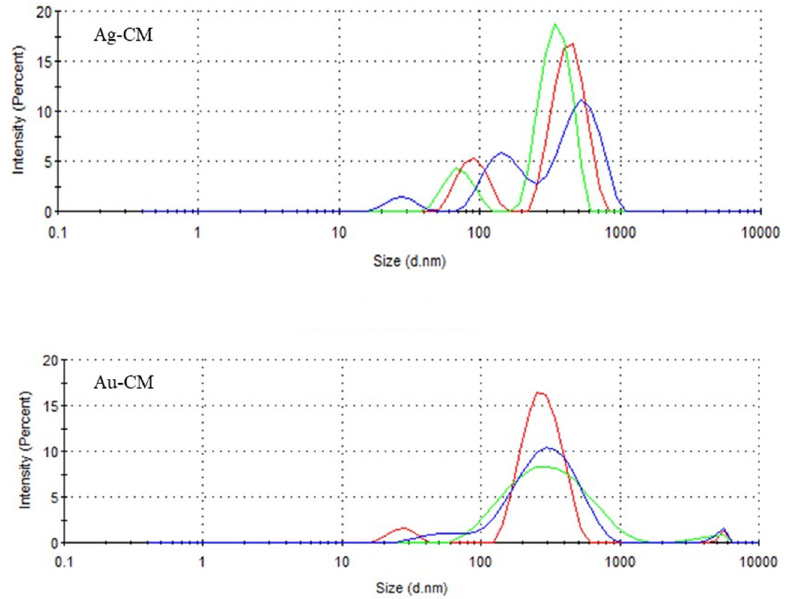
Figure 4. The hydrodynamic diameter of the silver and gold nanoparticles biosynthesized with Cornus mas fruit extract as source of reducing and capping agents.